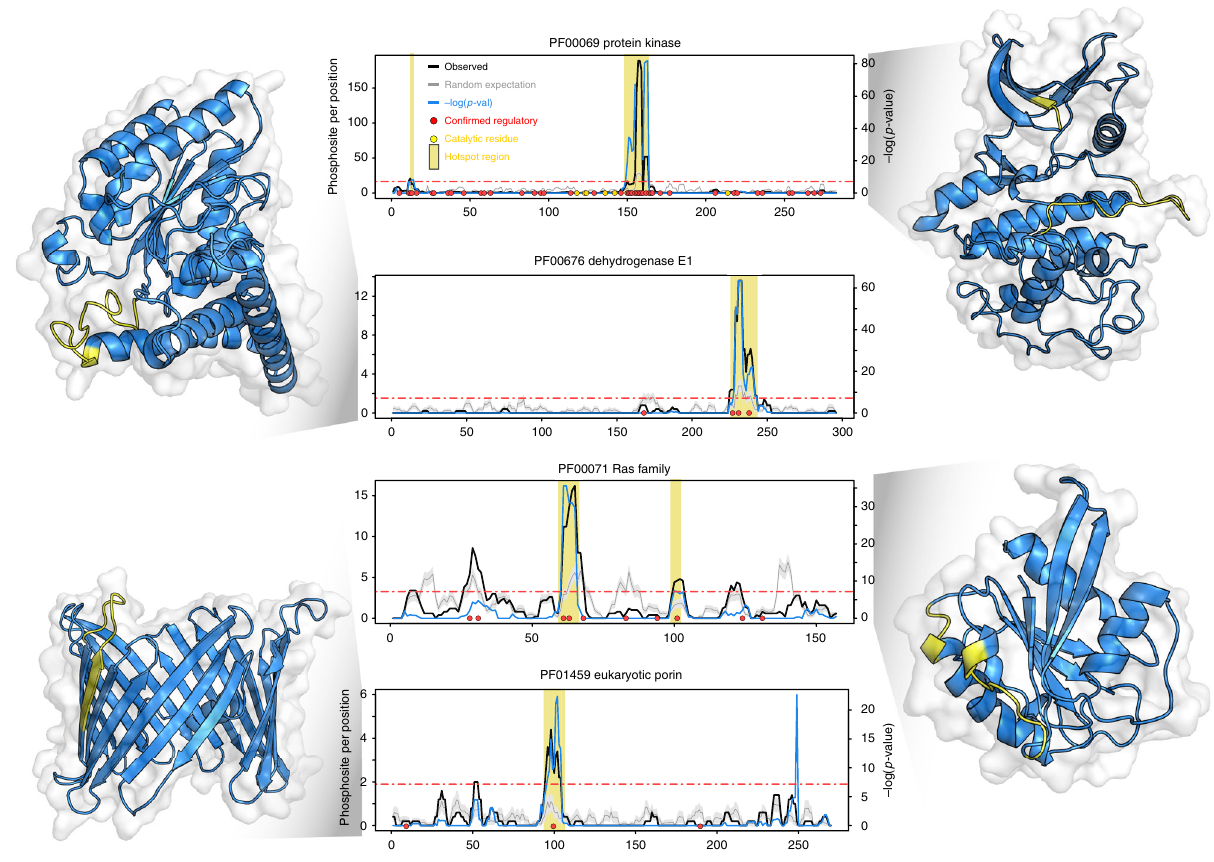
Fig. 2 Phosphorylation hotspots overlapping with human phosphosites of known function. For 4 protein domain families we show the enrichment over random of protein phosphorylation along the domain sequence. The average number of phosphosites observed per rolling window is plotted in a solid black line (observed). The background level of expected phosphorylation calculated from random sampling is shown in gray line, with standard deviations as gray band. The blue line represents the negative logarithm of p -value at each position (right y axis). A horizontal red line indicates a cut-off of the Bonferroni corrected p -value of 0.01. Positions with a − log( p -value) above this cut-off and average phosphosites per window higher than 2 are considered putative regulatory regions and highlighted under a vertical yellow bar. Red circles indicate human phosphosite positions with known regulatory function. In the structural representations the predicted hotspot regions are highlighted in